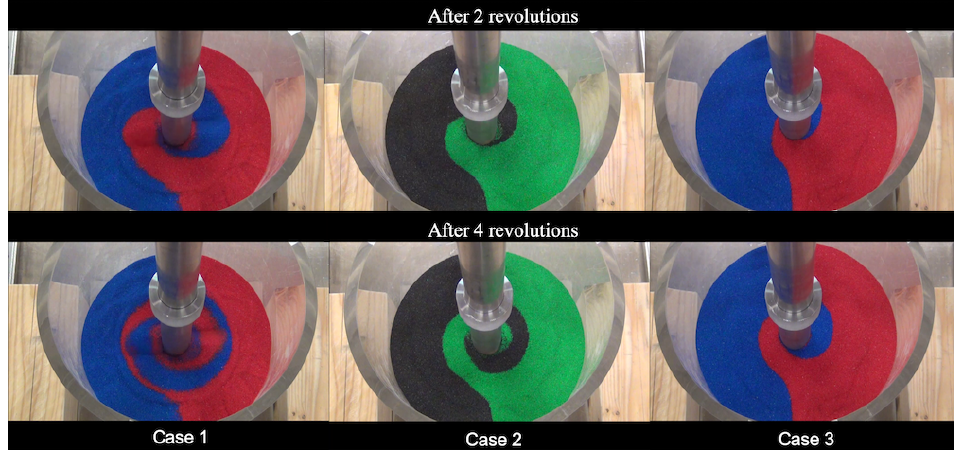
Figure 5. Surface mixing patterns from the three validation experiments after two and four revolutions with a rotation speed as 10